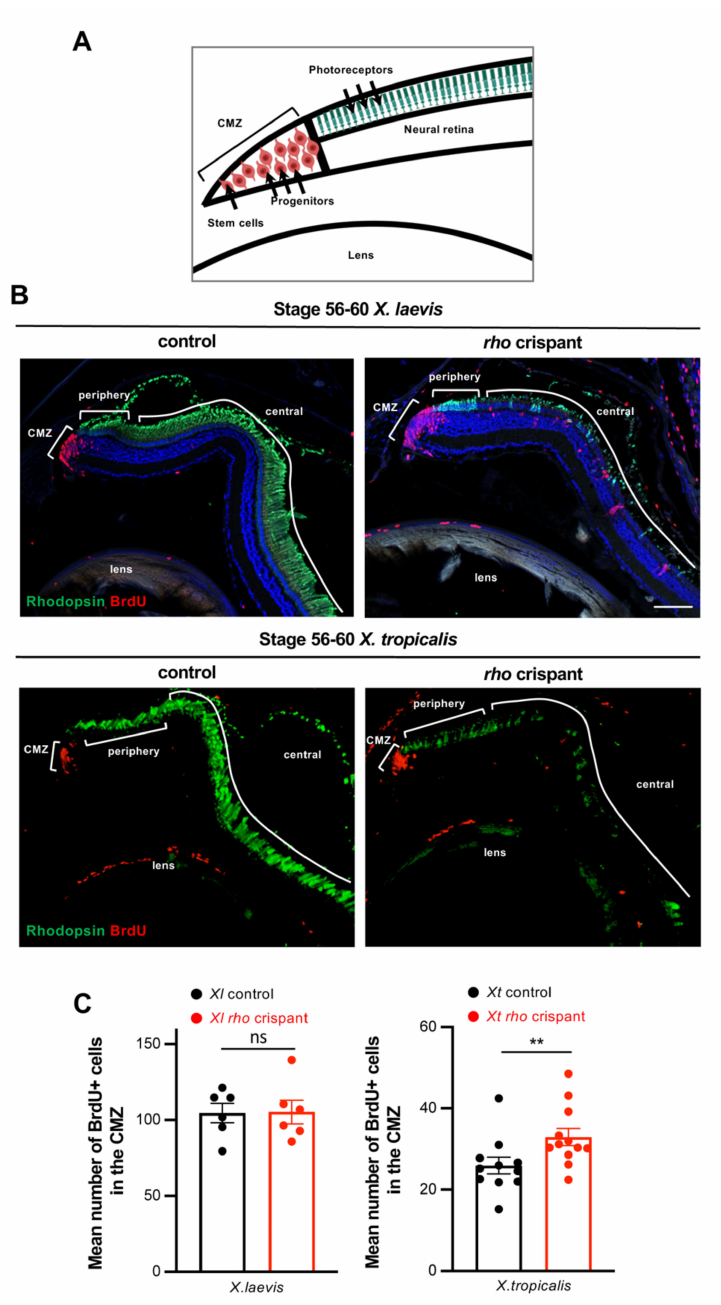
Figure 7. Analysis of proliferative CMZ cells in X. tropicalis and X. laevis rho crispants. ( A ) Schematic representation of the peripheral part of the retina. Stem cells and progenitors lie at the tip within